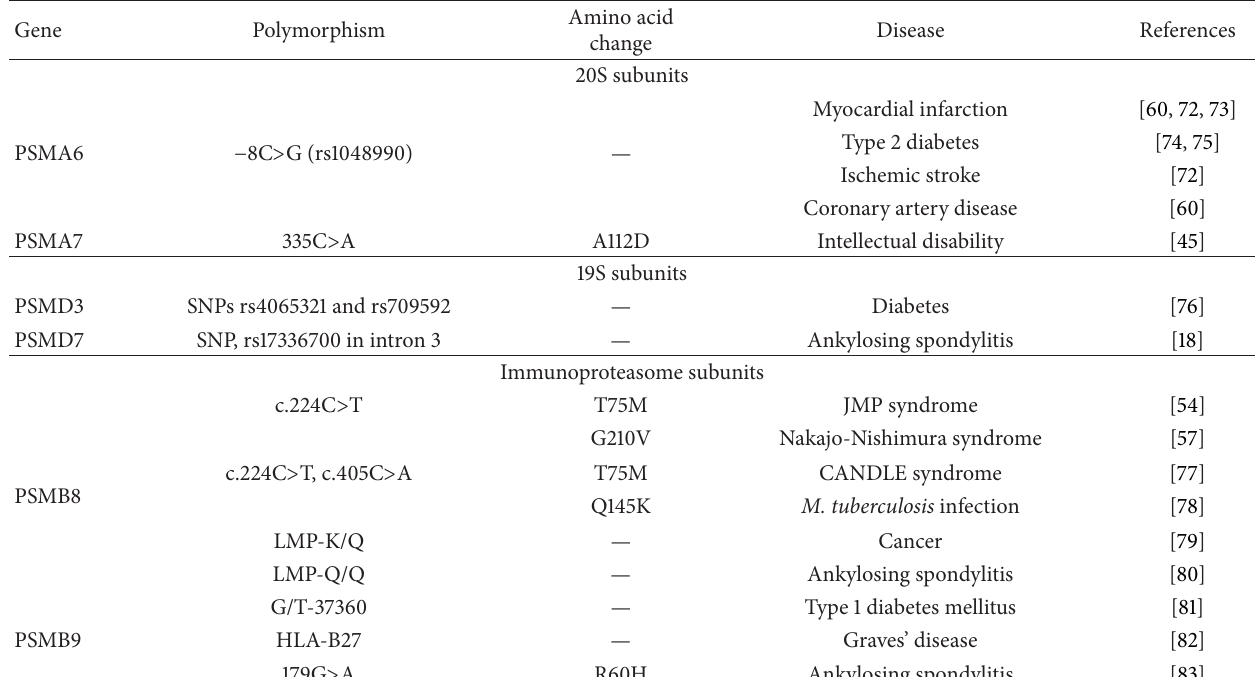
Table 2: Polymorphisms in proteasome genes associated with human